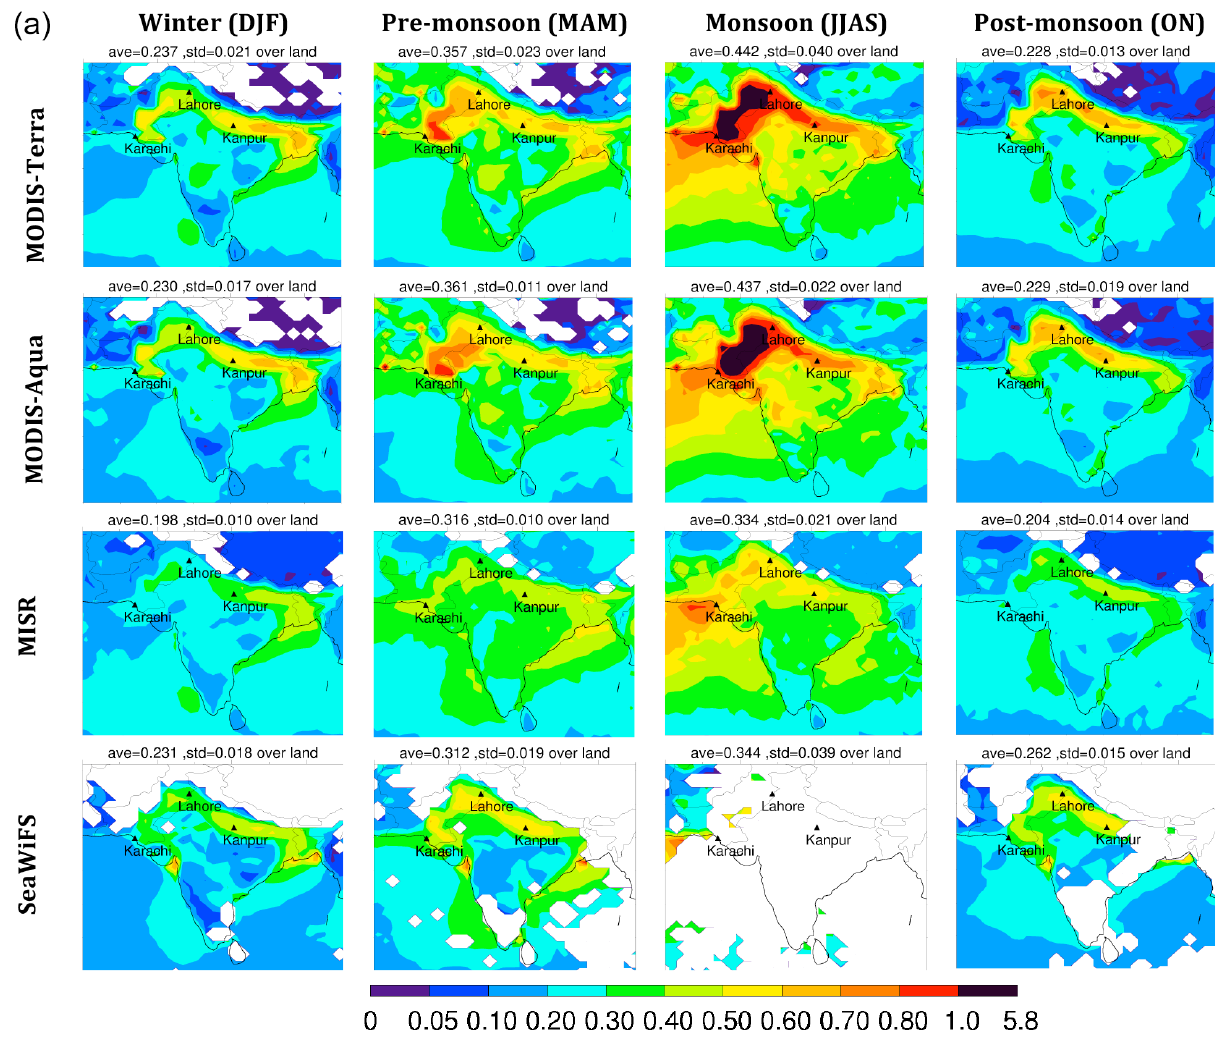
Figure 7. (a) Spatial distribution of AOD over South Asia in four seasons averaged for 2000–2007 from four satellite data sets (MODIS- Terra, MODIS-Aqua, MISR, and SeaWiFS). The corresponding area-averaged seasonal mean AOD value and standard deviation over land is listed on each panel. Three AERONET stations used in this study are labeled in the maps for reference. Area in white indicates no retrieval available due to the presence of bright surface or frequent cloud